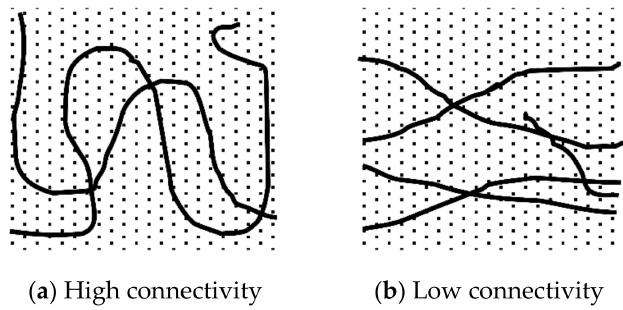
Figure 7. Schematic drawing of the di ff erent connectivity